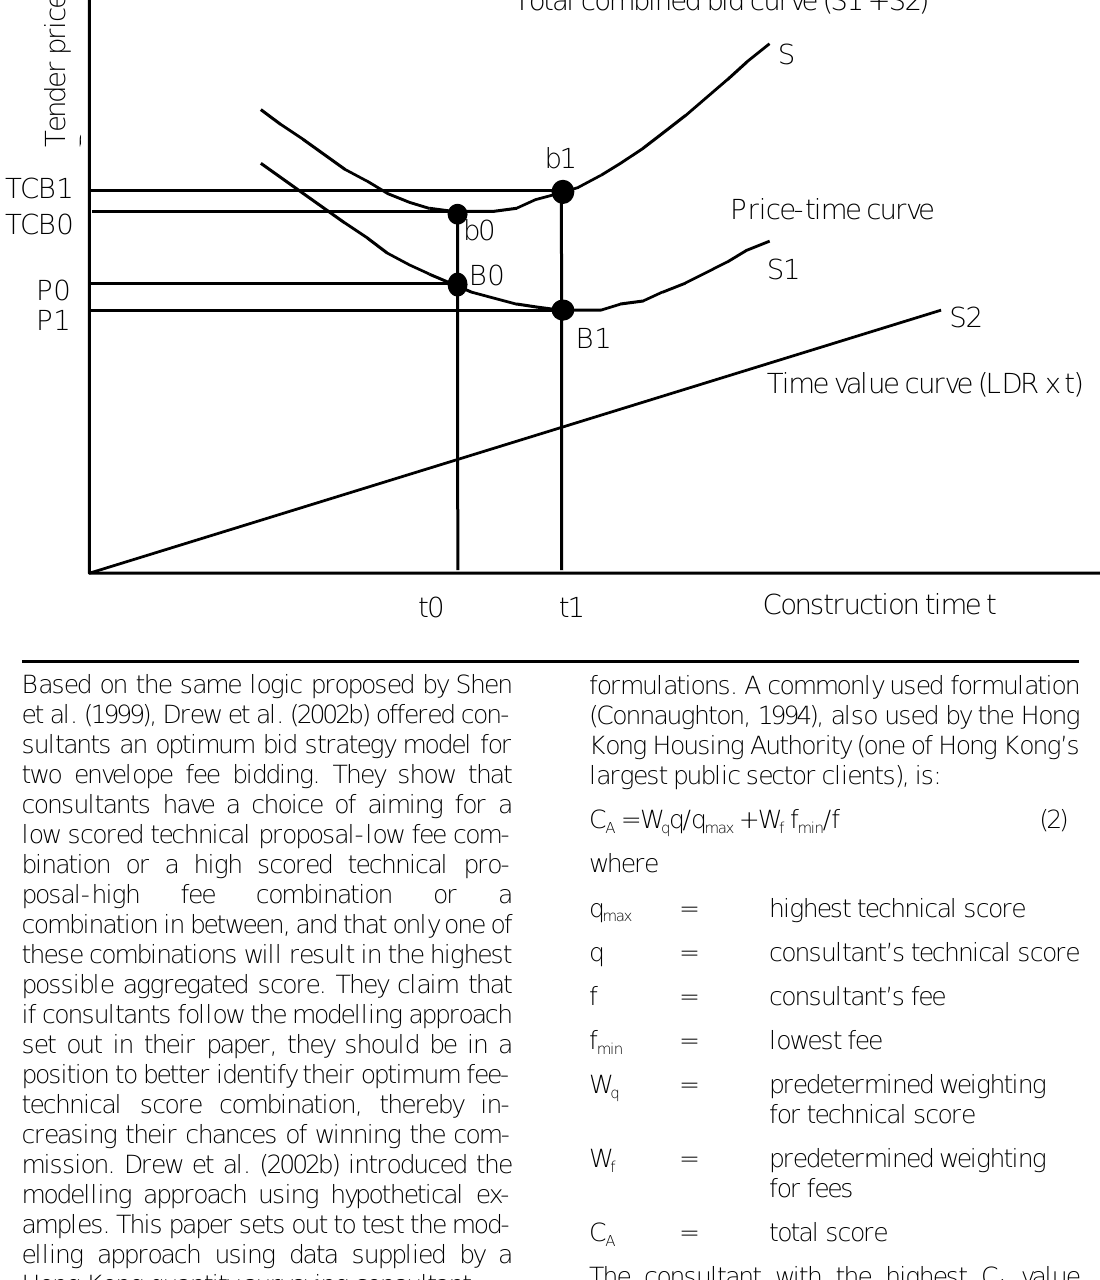
Figure 1: The price-time relationship between the contractor’s price-time curve (S client’s price-time curve (S) (Source: Shen et al.